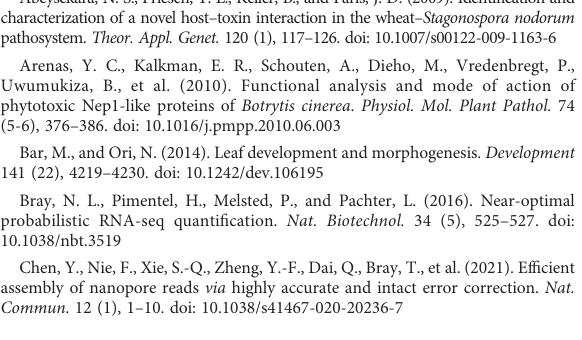
SUPPLEMENTARY INFORMATION 1 Detailed procedure for protein preparation for Mass Spectrometry analysis. SUPPLEMENTARY DATA 1 Detailed information of orthogroups, and Interproscan results of speci fi c groups of proteins. SUPPLEMENTARY FIGURE 1 Secretome conservation of three Botrytis spp. Presence or absence of secreted protein genes among B. cinerea , B. elliptica and B. squamosa are indicated by dark and light blue, respectively. SUPPLEMENTARY FIGURE 2 Leaf responses observed at 3dpi caused by in fi ltration of crude CF samples obtained from liquid cultures of B. squamosa and B. elliptica on leaves of N. benthamiana , lily and onion visualized with normal light and with the red light imaging system. 1 = B. elliptica grown in GB5_lily; 2 = B. elliptica grown in GB5_onion; 3 = B.squamosa grown in GB5_lily; 4 = B. squamosa grown in GB5_onion; 5 = GB5_onion mock; 6 = GB5_lily mock. SUPPLEMENTARY FIGURE 3 Leaf responses observed at 3dpi caused by in fi ltration of AS precipitated compounds contained in the CF samples in N. benthamiana , lily and onion visualized with normal light and with the red light imaging system. A = AS precipitation of B. elliptica CF grown in GB5_lily; B = AS precipitation of B. elliptica CF grown in GB5_onion; C = AS precipitation of B. squamosa CF grown in GB5_lily; D = AS precipitation of B. squamosa CF grown in GB5_onion; E = mock dialysis buffer. SUPPLEMENTARY DATA 2 Expression levels and functional annotation of the 85 shared proteins detected in the culture fi ltrates of B. squamosa and B. elliptica